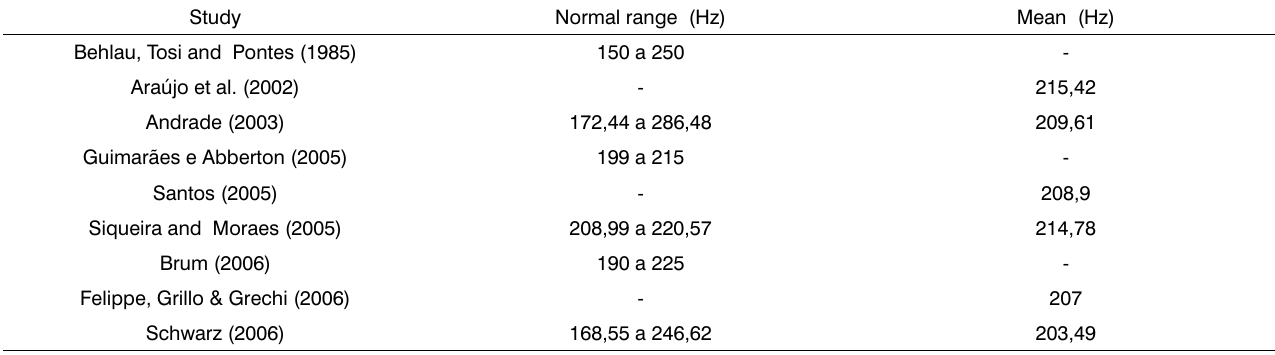
Table 1. Normal values for the female